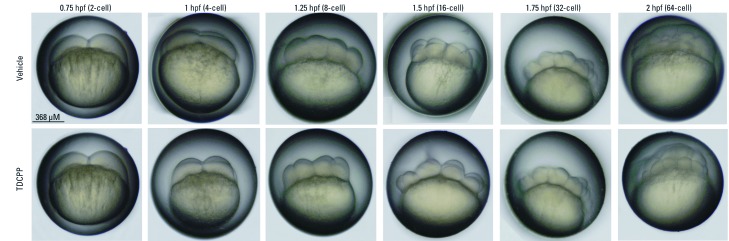
Effect of TDCPP on cell morphology during cleavage. Brightfield images of six different stages of cleavage in embryos treated with vehicle (0.1% DMSO) or 3 µM TDCPP under static conditions. TDCPP exposure did not appear to have adverse impacts on gross cell morphology (size, shape, viability) or cell cycle progression during cleavage. Images are representative of 60 embryos per treatment.